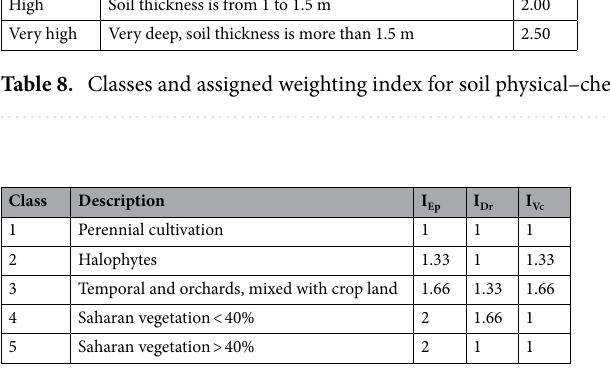
Table 9. Classes and assigned weighting index for different vegetation